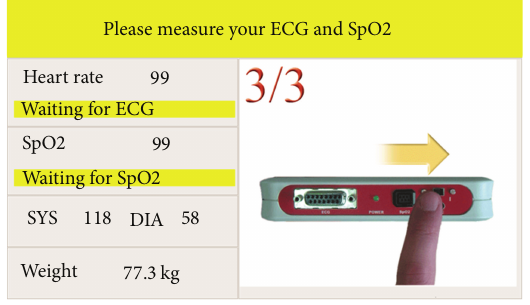
Figure 9: Example of the graphical user interface requesting a